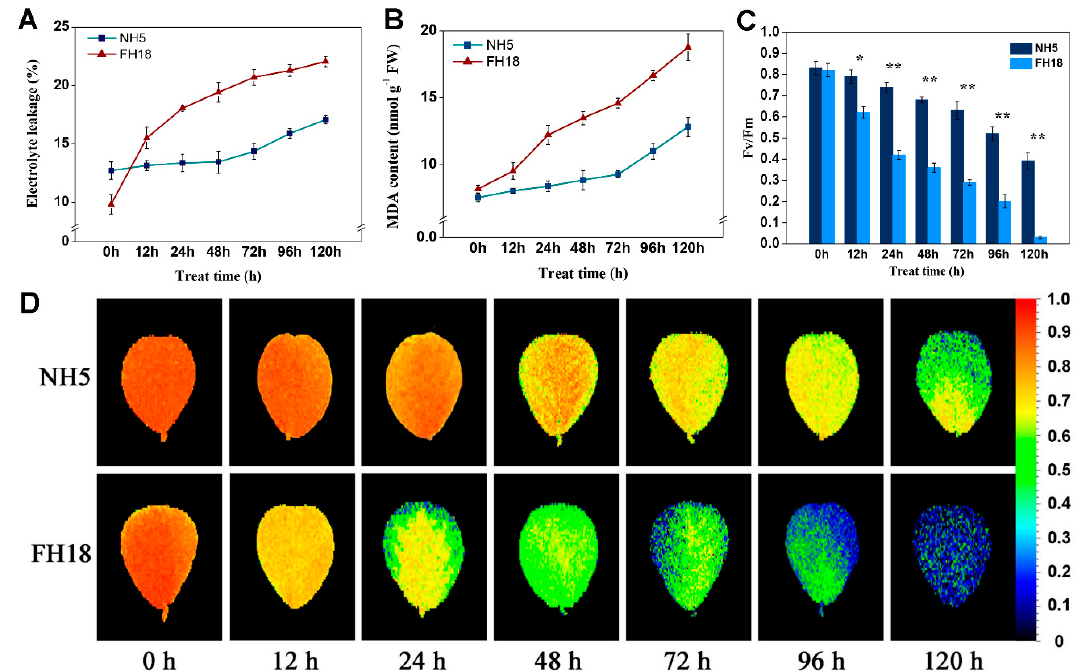
Figure 2. The physiological responses of the two peanut varieties to cold stress. ( A ) Electrolyte leakage of Nonghua 5 (NH5) and Fuhua18 (FH18) under cold stress. ( B ) Malondialdehyde of NH5 and FH18 under cold stress. ( C ) The maximum photochemical efficiency of PSII of NH5 and FH18 under cold stress. ( D ) The chlorophyll fluorescence in-situ imaging of NH5 and FH18 under cold stress. Error bars represent the SD of the means ( n = 3). * p < 0.05; ** p < 0.01.